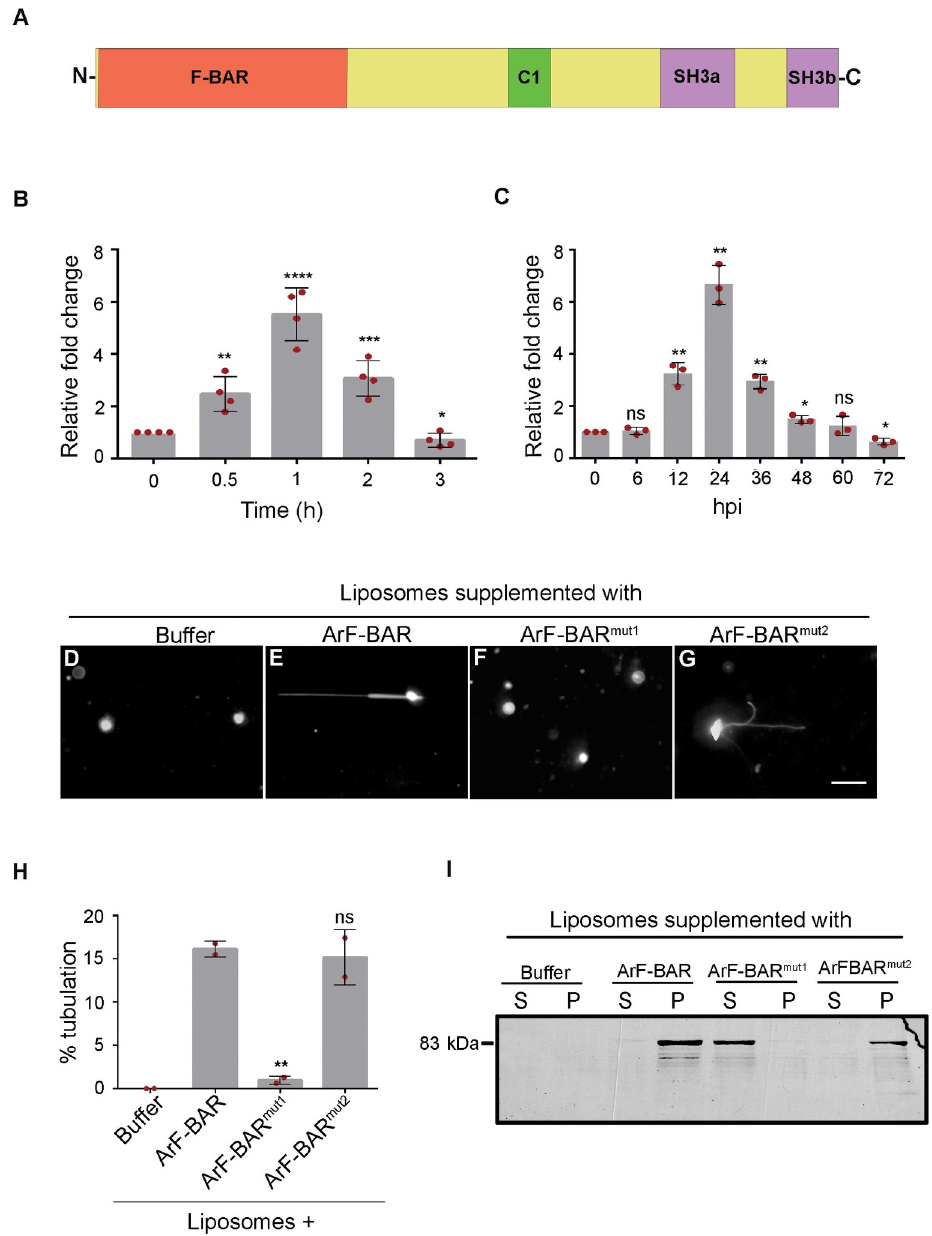
Fig 1. ArF-BAR is a bonafide stress induced membrane tubulating protein. Schematic representation of domain organization of ArF-BAR protein. It has a F-BAR domain (amino acids 7–253), a C1 domain of Protein Kinase C1, PKC1 (amino acids 407–456) and two consecutive SH3 domains (SH3a; amino acids 572–651 and SH3b; amino acids 705–760). (B) Relative fold change in the ArF-BAR transcript level of 5 days axenically grown potato dextrose broth mycelium culture of Ascochyta rabiei post 250 μ M menadione treatment. The treated mycelia samples were collected every 0.5 h and the expression was analysed with qRT-PCR. (C) Relative fold change in the transcript level of ArF-BAR post A . rabiei conidial suspension inoculation. The conidia inoculated chickpea aerial tissue was collected up to 72 hpi and expression was analysed by qRT-PCR. (D-G) Membrane deforming activity of ArF-BAR. The bar represents 20 μ m. (D) The liposomes remain spherical in presence of protein resuspension buffer, acting as control. (E, G) Tubulation of synthetic liposomes after addition of the recombinant ArF-BAR and ArF-BAR mut2 proteins. (F) Liposome tubulation activity is insignificant in ArF-BAR mut1 . (H) The bar chart shows the percentage of the tubule formed by liposomes in presence of native and mutated recombinant proteins. Out of 150 liposomes, the percentage of the tubule formation was counted in each set of experiment. (I) Liposome co-sedimentation assay, where the ArF-BAR and ArF-BAR mut2 recombinant protein bound with lipid membranes (liposome) were found in pellet, while